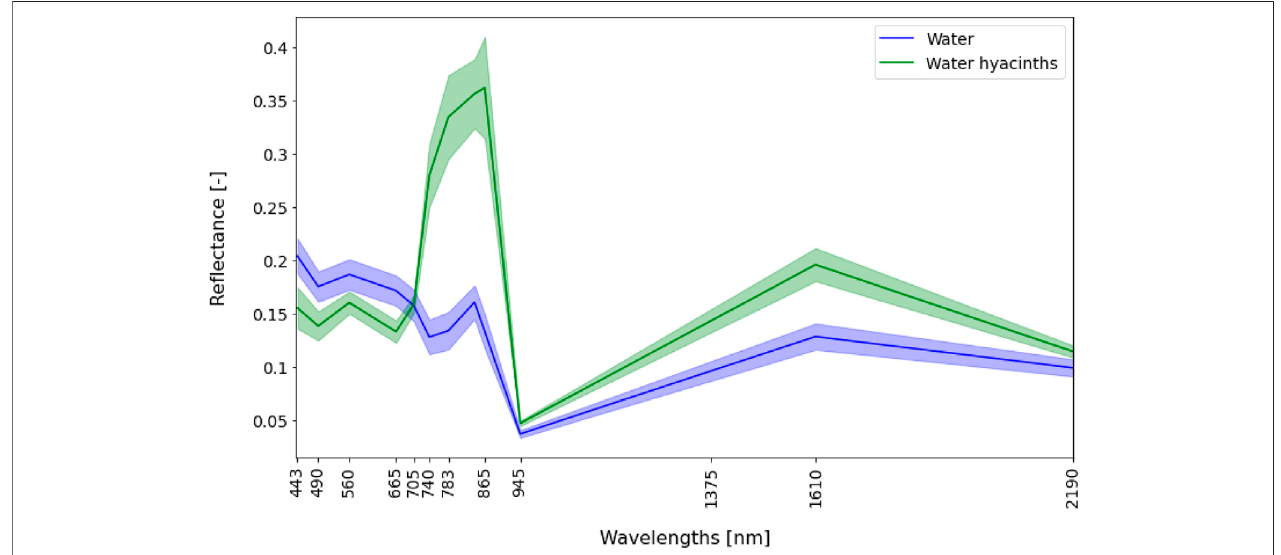
FIGURE 3 | Mean spectral signatures of water hyacinths ( n (cid:1) 26) and water ( n (cid:1) 12) from the Sentinel-2 images taken on May 22, 2020. The x -axis shows the Sentinel-2 MSI spectral range from visible blue light at 490 nm, to short-wave infrared light at 2,190 nm. The y -axis shows remote sensing re fl ectance (unitless) from Sentinel-2 for water hyacinths and water for selected